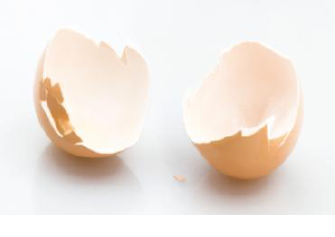
Figure 5. Eggshell. Figure 5. Eggshell.